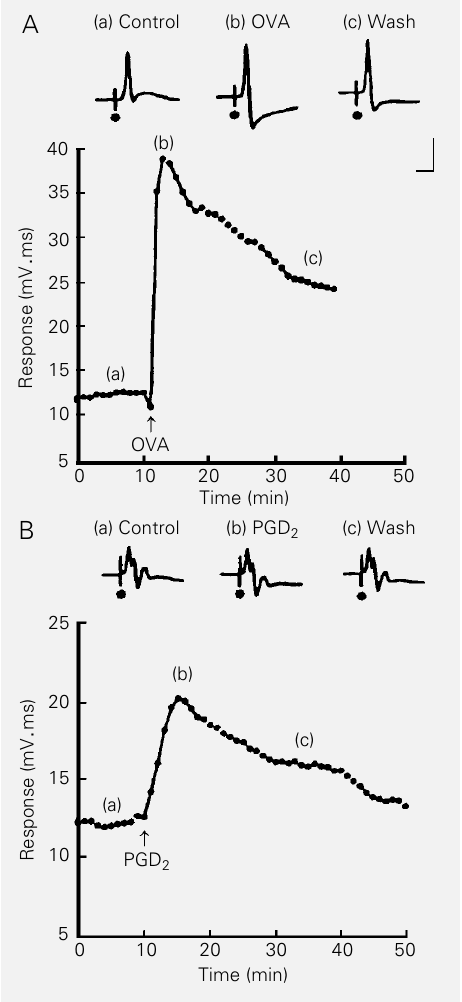
Figure 1 - Antigen- and prosta- glandin D 2 (PGD 2 )-induced long- term potentiation in the superior cervical ganglion in vitro . Repre- sentative course of variation of the compound action potential (CAP) integral (mV.ms; ordinate) recorded before, during (5 min) and after ganglionic exposure to a sensitizing antigen (ovalbumin (OVA); 10 (cid:181)g/ml) in A or to PGD 2 (1.0 (cid:181)M) in B. The arrow indi- cates the time when the chal- lenge started. Insets on top of each panel: actual CAP voltage recordings under control (a) and experimental (b) conditions dur- ing exposure to OVA (panel A) or to PGD 2 (panel B) and after wash (c). Each data point repre- sents the average magnitude of the integral of 12 postganglionic CAPs evoked at 0.2 Hz. Calibra- tion: 1 mV, 10